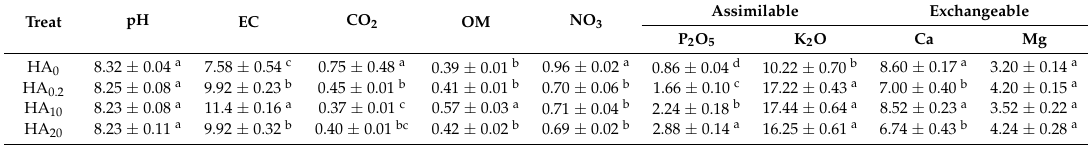
Table 3. Soil chemical property of soil following brown coal humic acid fertilizer application.